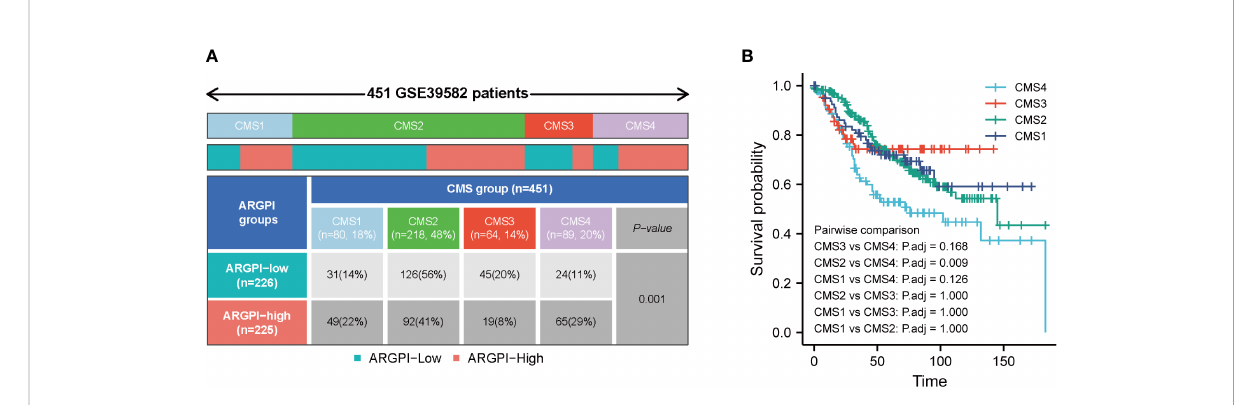
FIGURE 6 Distribution of consensus molecular subtypes (CMS) in different ARGPI subgroups (A) and prognostic analysis of CMS (B)